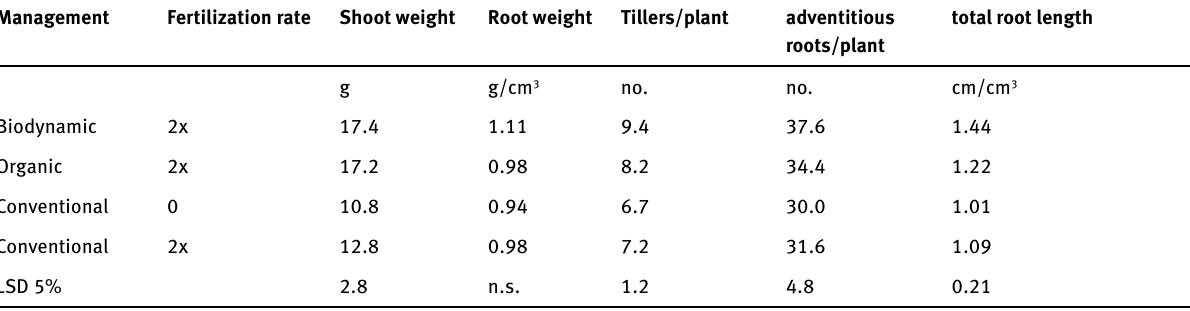
Table 1: Effects of management on wheat characteristics at jointing in 1985